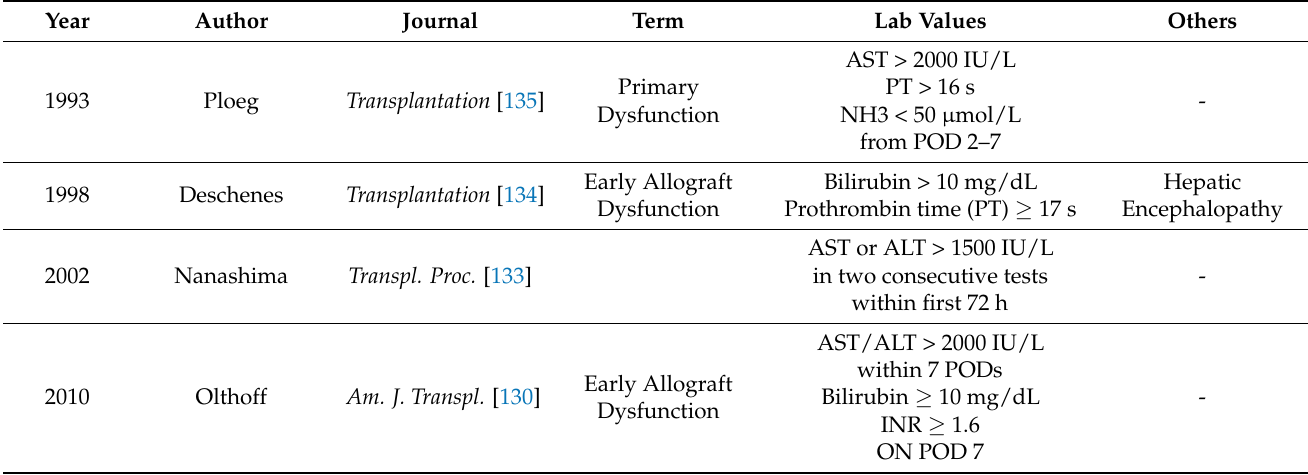
Table 1. Historical definitions of early allograft dysfunction